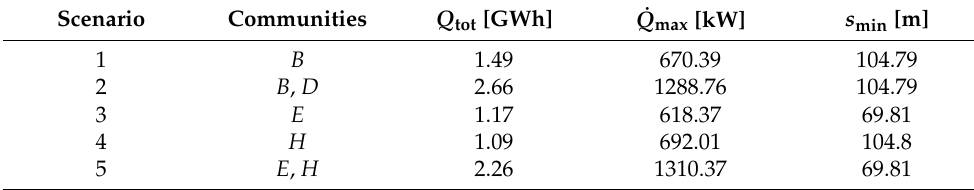
Table 7. Specified separation scenarios of the generic district heating system.